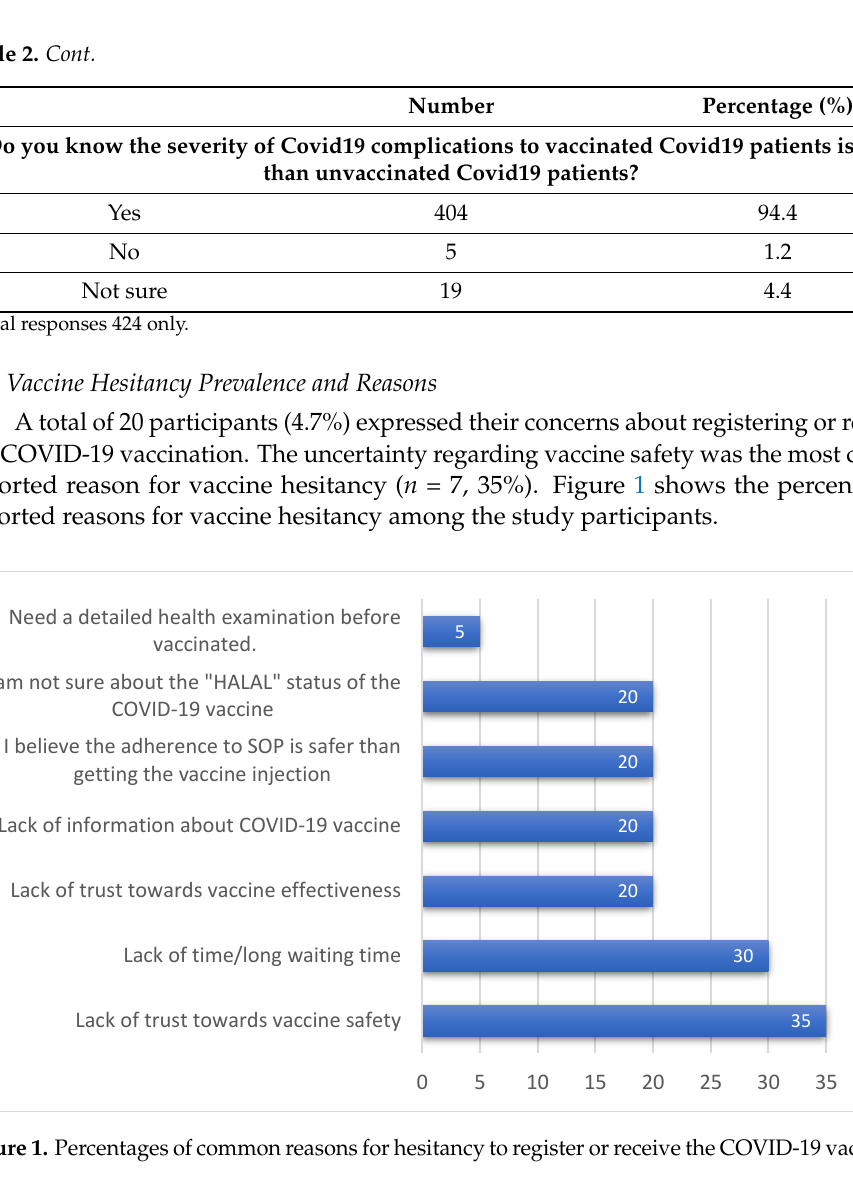
Table 3. Information on vaccine types, side effects, and sources of vaccine-related information.